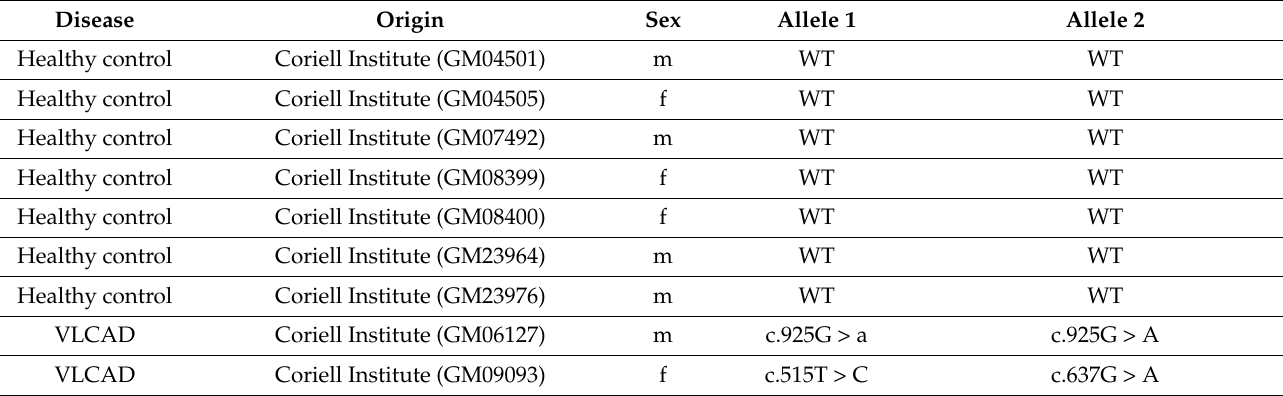
Table 3. Detailed information on the cell line used in this